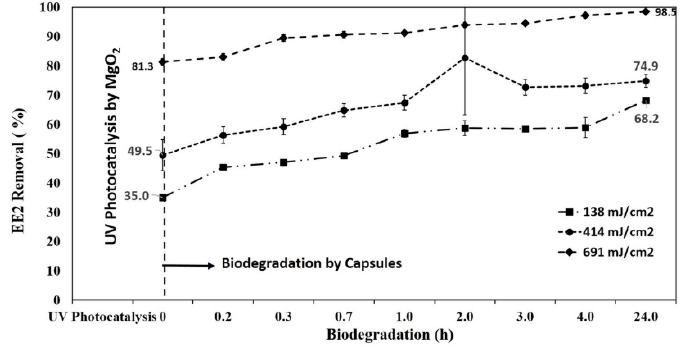
Figure 8. Sequential photocatalysis–biodegradation of 3 ppm EE2 in 10 mm phosphate buffer.